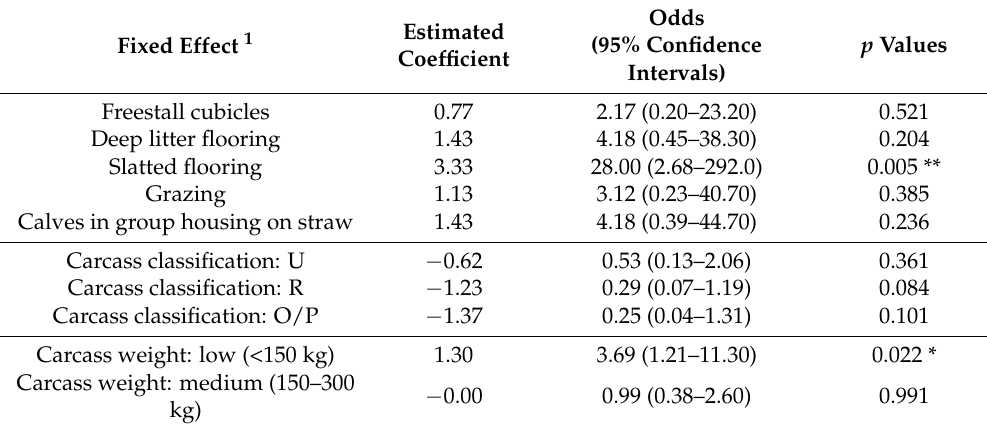
Table 2. Estimated influencing fixed factors (including associated odds) for the abomasal mucosa lesions of the slaughtered cattle compared to the intercept.